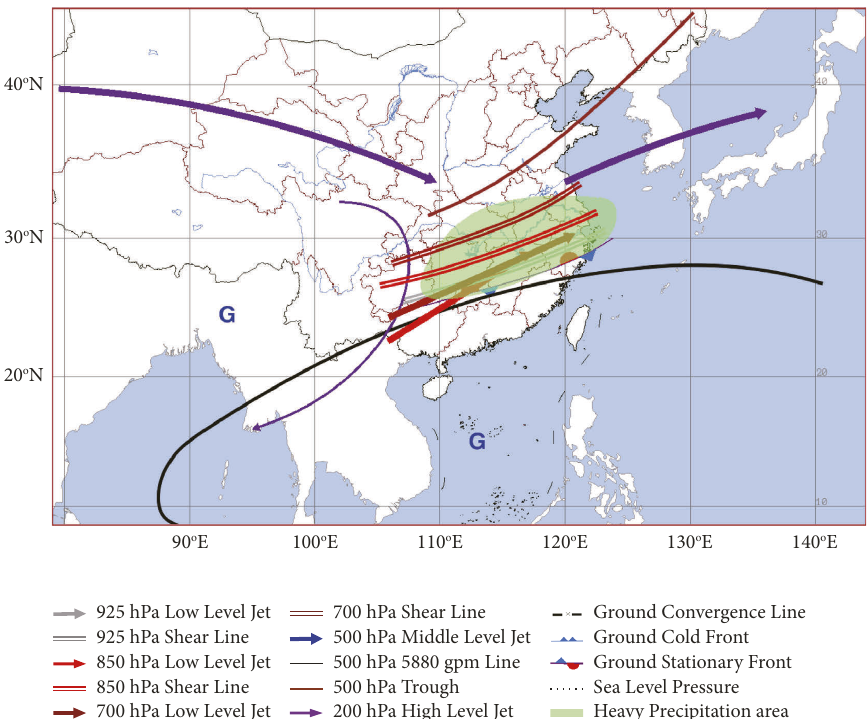
Figure 2: Conceptual model of the static front pattern rainstorms.